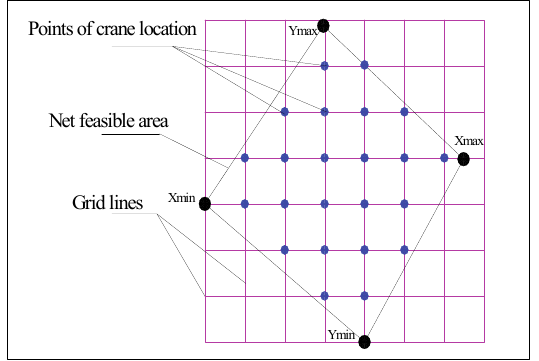
Fig. 4. Available crane